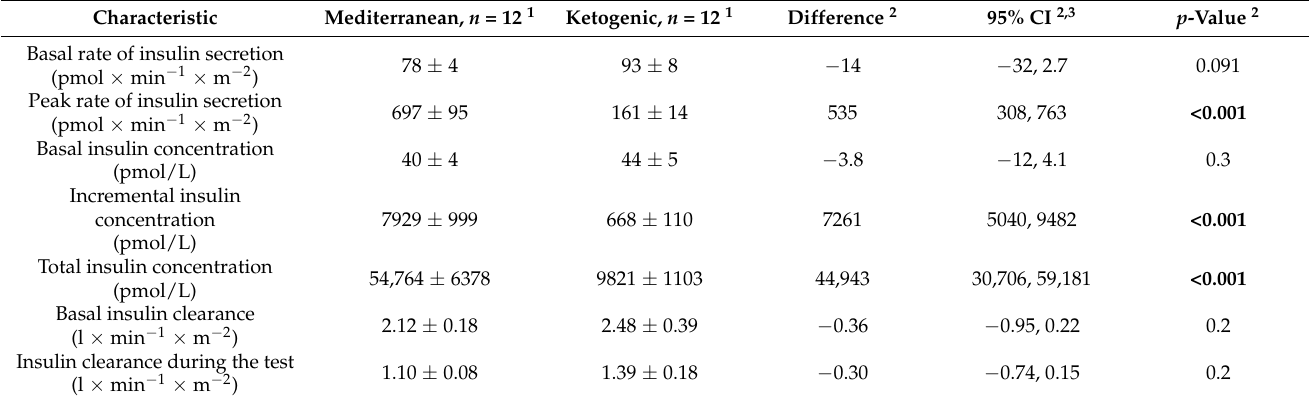
Table 3. Differences between meals in insulin secretion, insulin concentration, and insulin clearance.